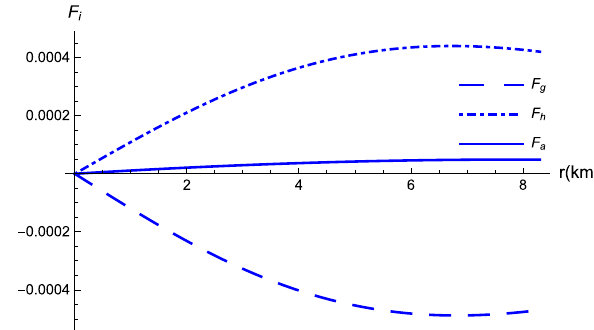
Fig. 17 Behavior of forces in SAX J1808.4-3658